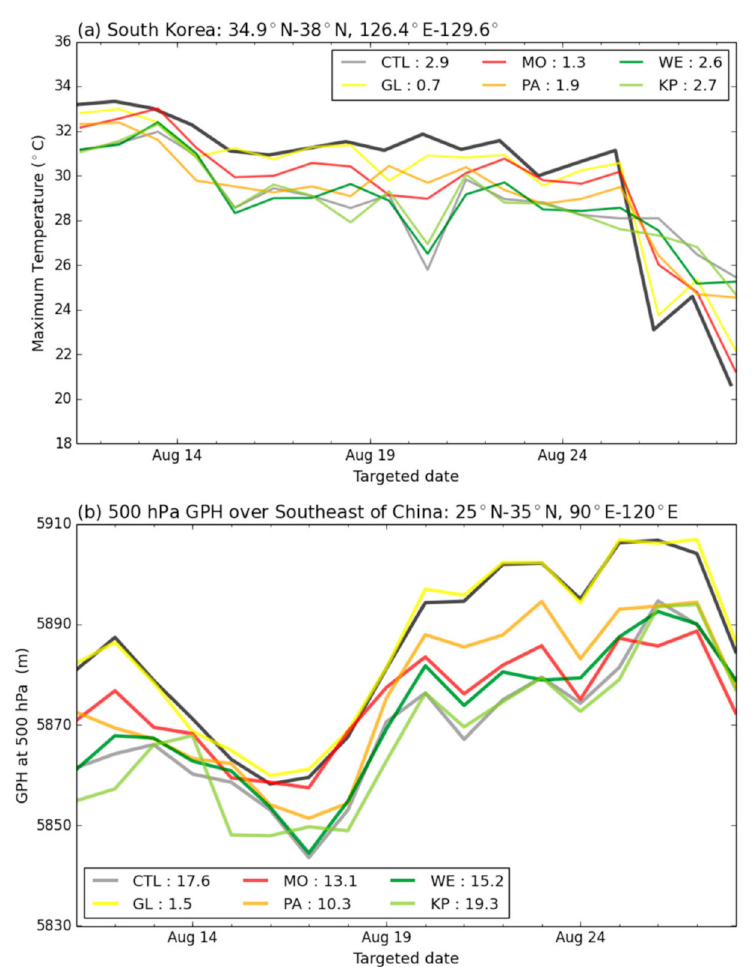
Figure 6. Time series of the 7-day forecast maximum temperature ( ◦ C) in each nudged experiment averaged over ( a ) South Korea (34.9 ◦ N–38 ◦ N, 126.4 ◦ E–129.6 ◦ E) with the MetUM analysis (black line) and ( b ) 500 hPa geopotential height over Southwest China (25 ◦ N–35 ◦ N, 90 ◦ E–120 ◦ E) with the MetUM analysis (black line). Numbers in box mean averaged RMSE of each experiment. Table 2. RMSE of 7-day forecasts of each nudged experiment for three variables. Values are averaged around Korea (25 ◦ N–50 ◦ N, 115 ◦ E–140 ◦ E). Variables CTL GL MO PA WE KP 500 hPa geopotential height (m) 31.16 200 hPa horizontal wind (m / s) Maximum temperature at 1.5 m